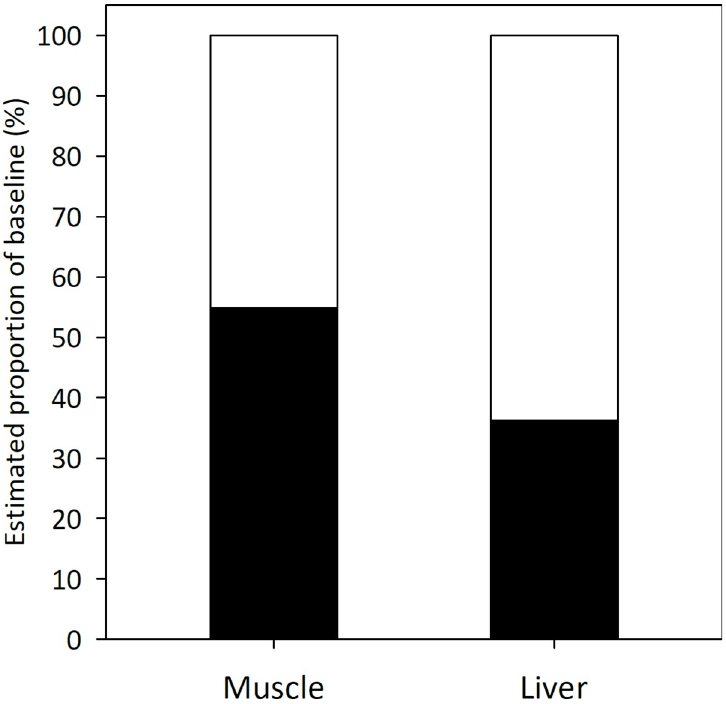
Fig 6. Relative contribution of two regional baselines to yellowfin tuna tissues. Isotopic baseline contributions (%) of the northern (black) and central-southern (white) Gulf of Mexico to yellowfin tuna caught in the southern and central region of the GM, muscle and liver tissues based on a two-source Bayesian mixing